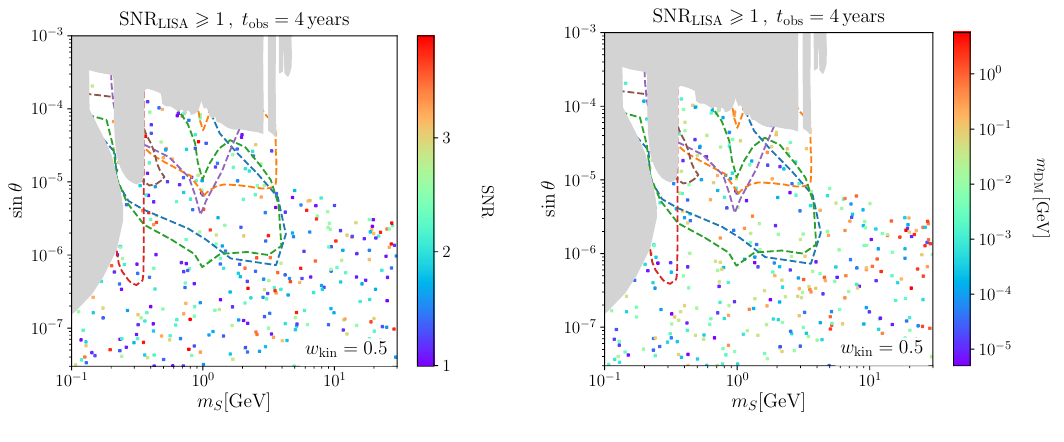
Figure 7 . Same as figure 5 but for w kin = 0 . 5 and an SNR computed for